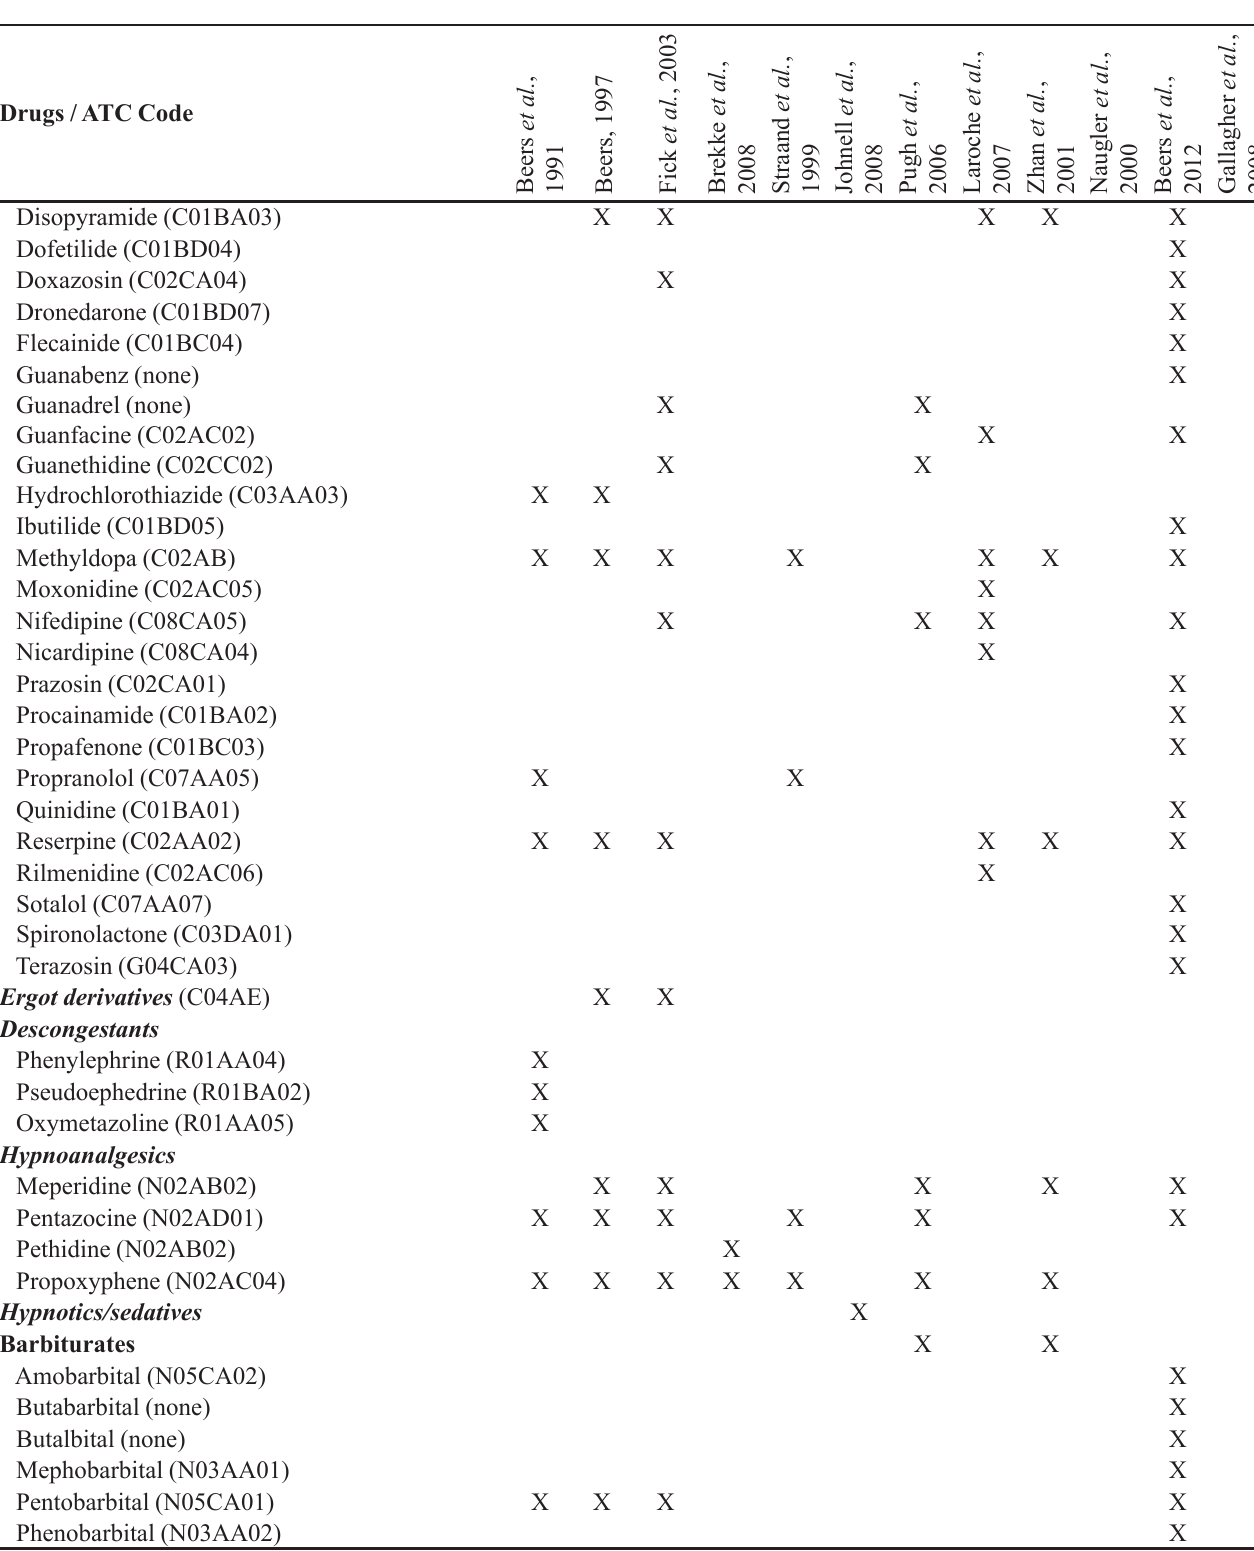
TABLE I - List of potentially inappropriate medications (PIM) for the elderly that should be avoided irrespective of diagnosis or clinical condition, according to the methods identified in PAHO (available in: http://regional.bvsalud.org/php/index.php), Lilacs and Pubmed databases, during the period between February and March 2010 (n=12)